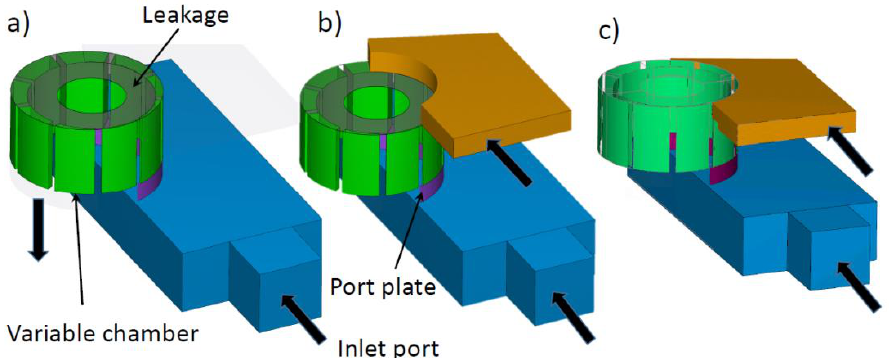
Figure 15. Model with a smaller diameter and the same displacement: ( a ) with chambers fed from only one side—M3, ( b ) with chambers fed from both sides through the cover—M4, ( c ) with chambers fed from both sides through a cutting on the stator—M5. The delivery volume is not shown.